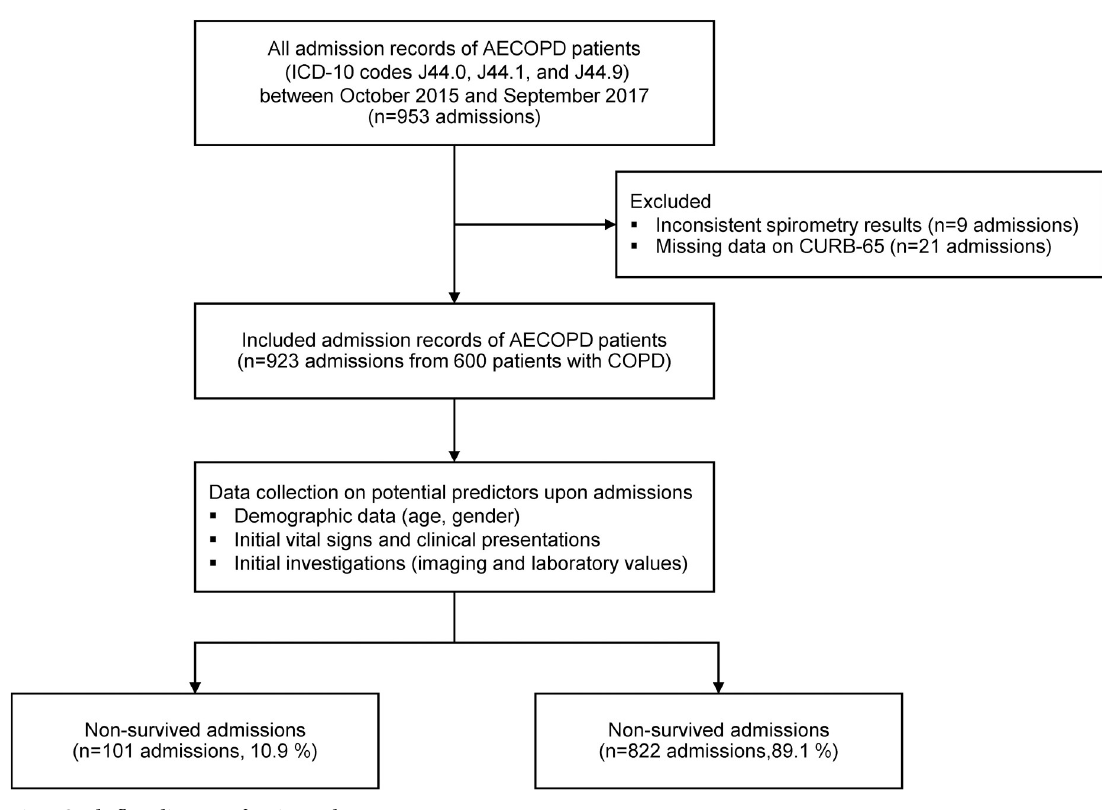
Fig 1. Study flow diagram of patient